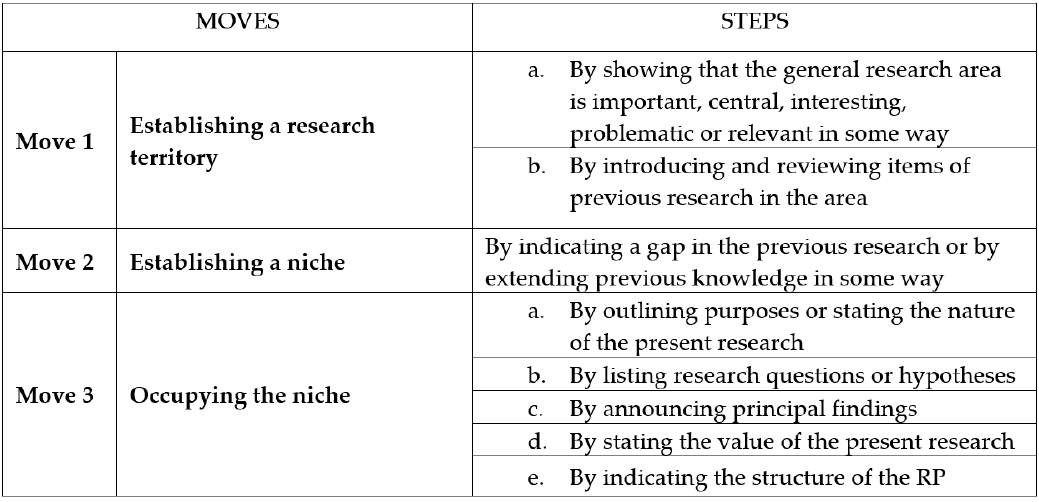
Figure 1. The CARS model (adapted from [39]).